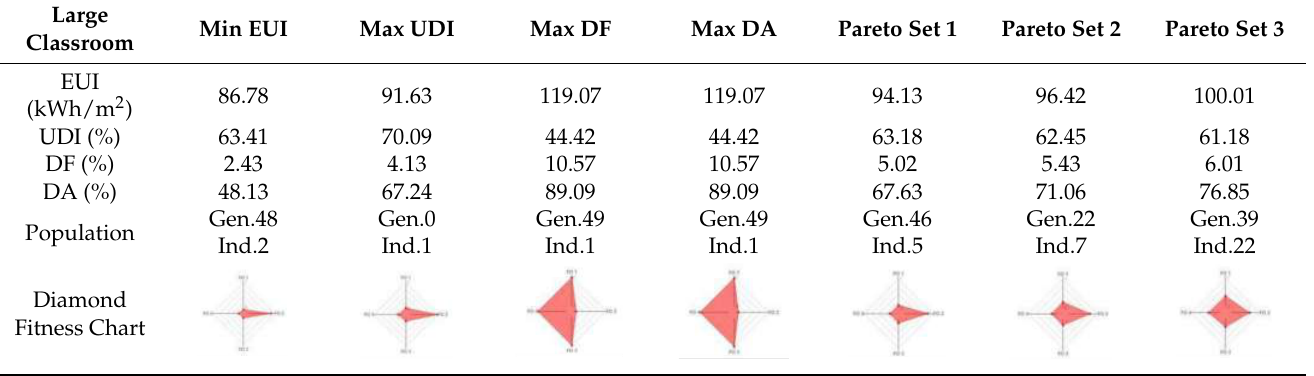
Table 17. The case of large-sized classrooms with window openings on the east and south facade.